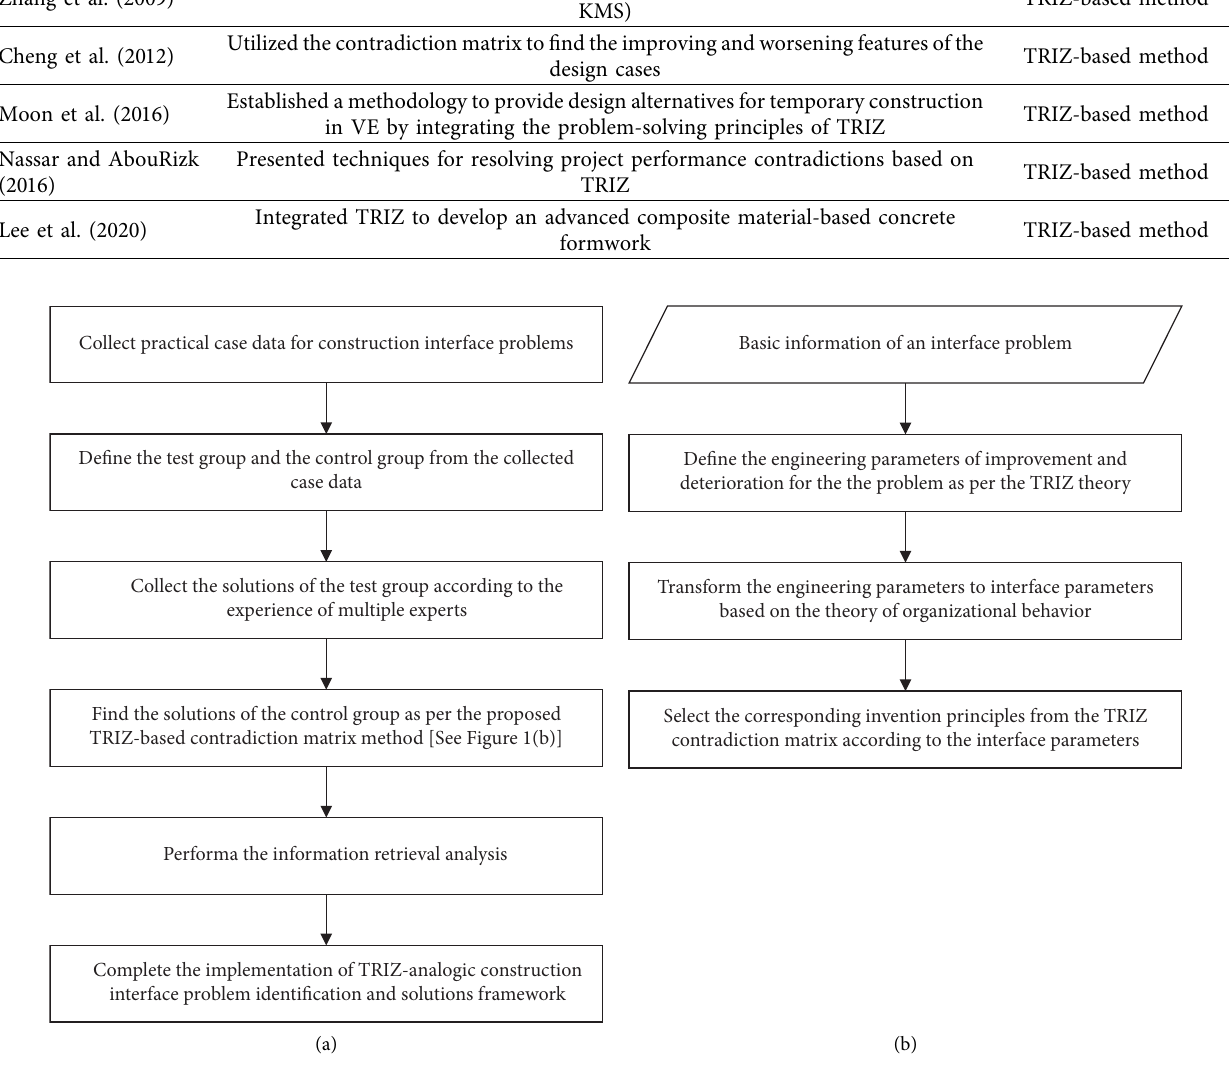
Figure 1: Research method diagram. (a) Primary procedure. (b) Application process of the TRIZ contradiction